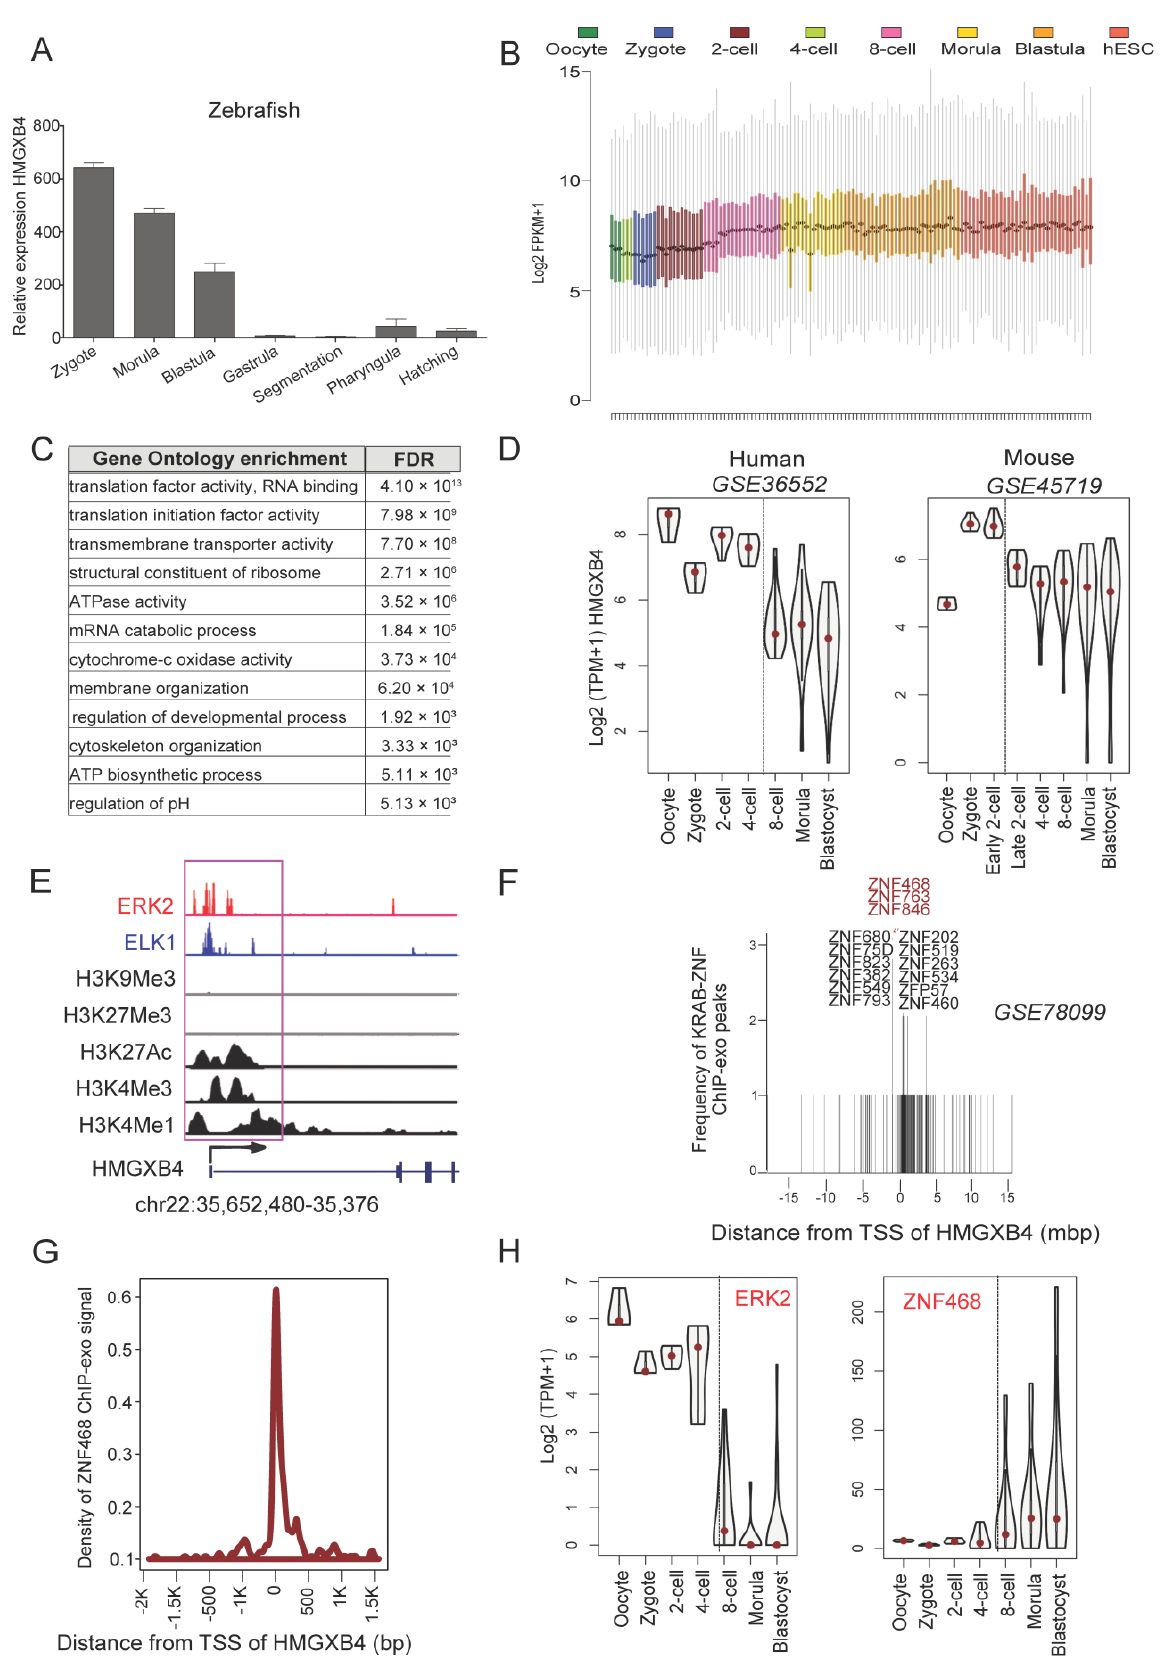
Figure 4. Transcription regulation of HMGXB4 in early development. ( A ) Transcription of HMGXB4 in developing zebrafish embryos (~100) collected at various stages of development, monitored by